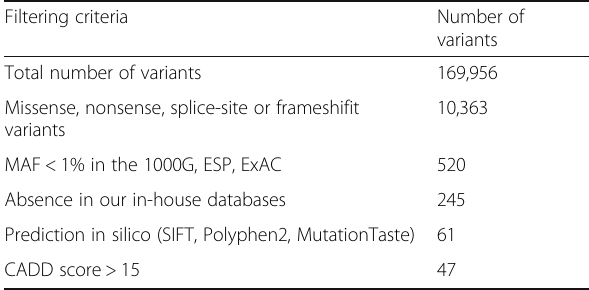
Table 1 Filtering strategy of the patient Filtering